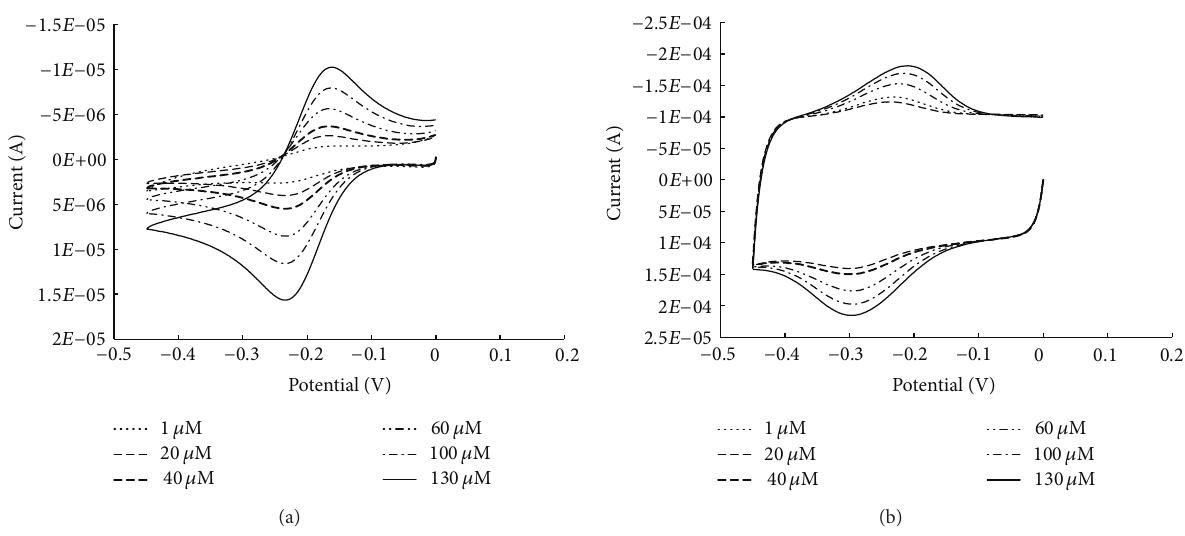
Figure 1: CVs of the (a) PANI- and (b) SWCNT-based aptasensors at different hexaammineruthenium concentrations. In all cases, the sweep rate was 0.1V/s. The observed area under the average cathodic peak from 1 𝜇 M to 130 𝜇 M due to addition of hexaammineruthenium is used for calculations in (1) and